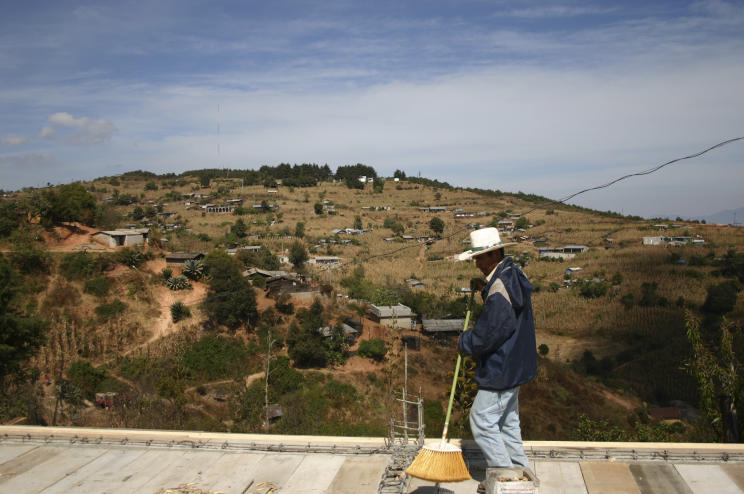
A Hometown of the Triqui People in Oaxaca State, MexicoThe hometown in the mountains of Oaxaca, Mexico, of many Triqui migrant laborers.